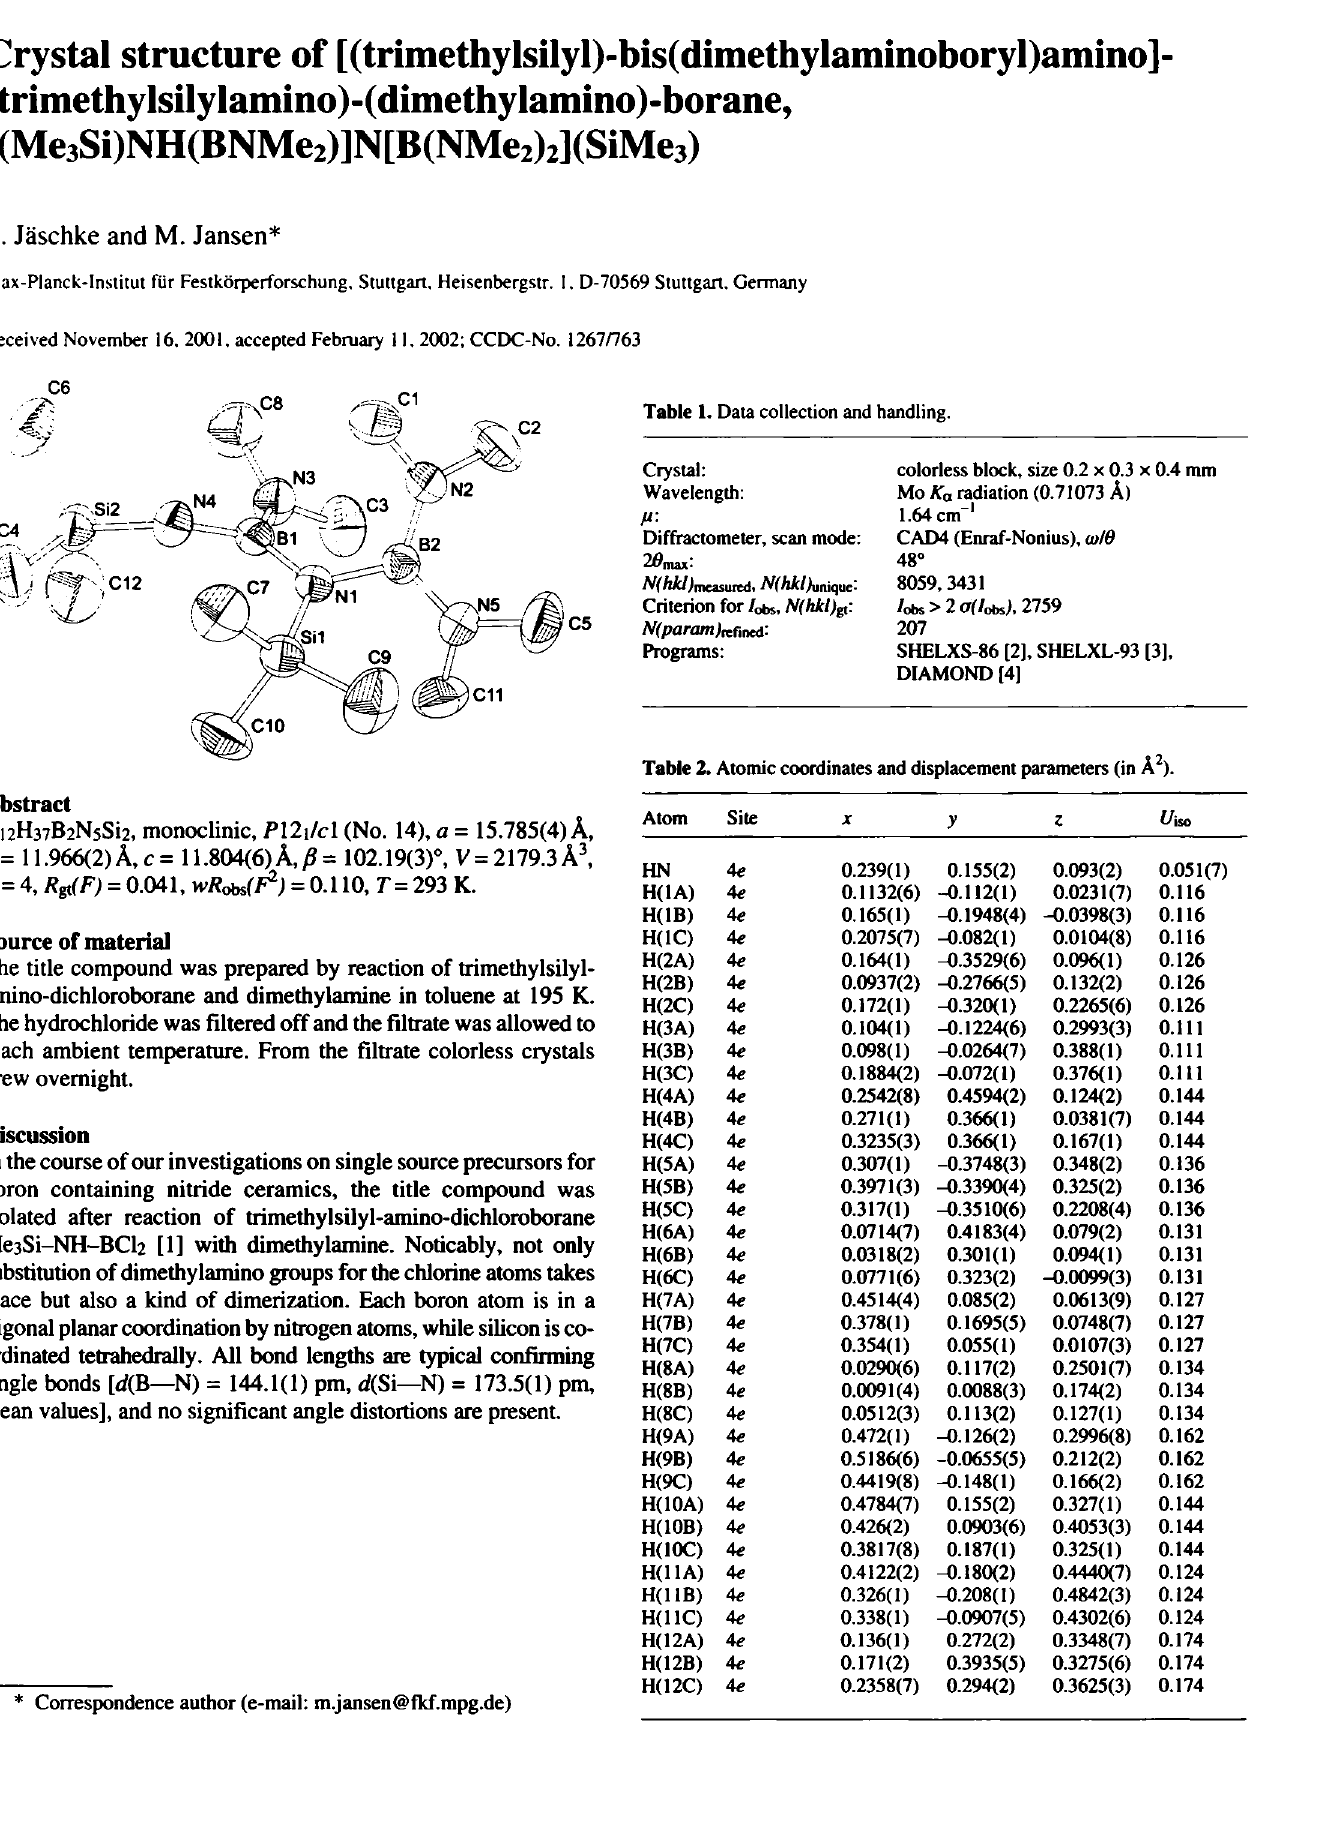
Table 2. Atomic coordinates and displacement parameters (in À 2